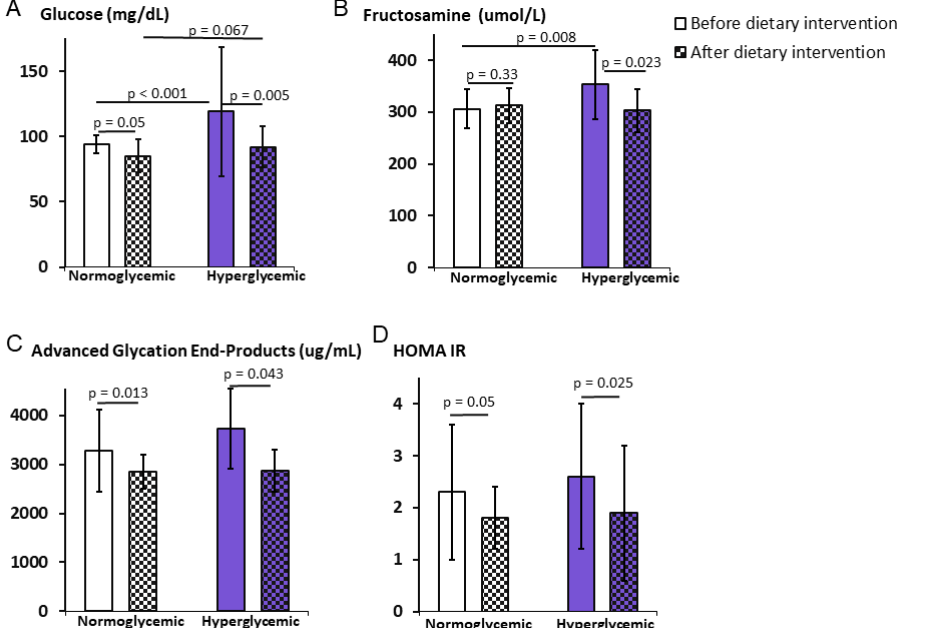
Figure 2. Improvement of carbohydrate profile of overweight hyperglycemic women as the result of the weight reduction program. Normoglycemic and hyperglycemic obese women were placed on a 6-month personalized weight reduction program consisting of a moderate calorie restriction and moderate exercise individualized to each patient. Glucose ( A ), fructosamine ( B ), advanced glycation products ( C ), and HOMA IR ( D ) were measured at the beginning and the end of the program. Data are mean ± SD. T -test significance: p ≤